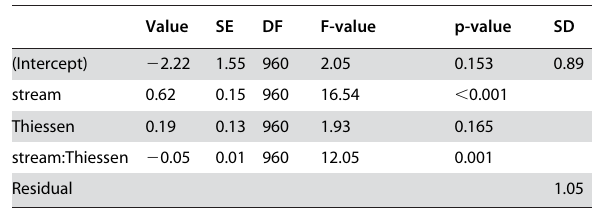
Variables are transformed (Table 2). Number of observations is 982, and number of groups 19. SE is Standard Error, SD is Standard Deviation and DF is degrees of